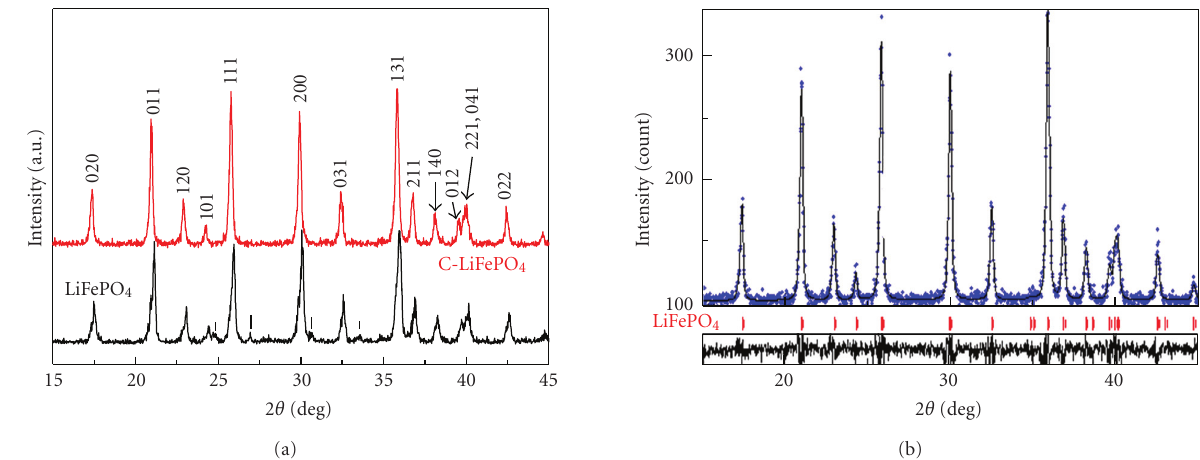
Figure 1: XRD patterns of LiFePO 4 material (a) with and without carbon and (b) Rietvield refinement of C-LiFePO 4 composite material.